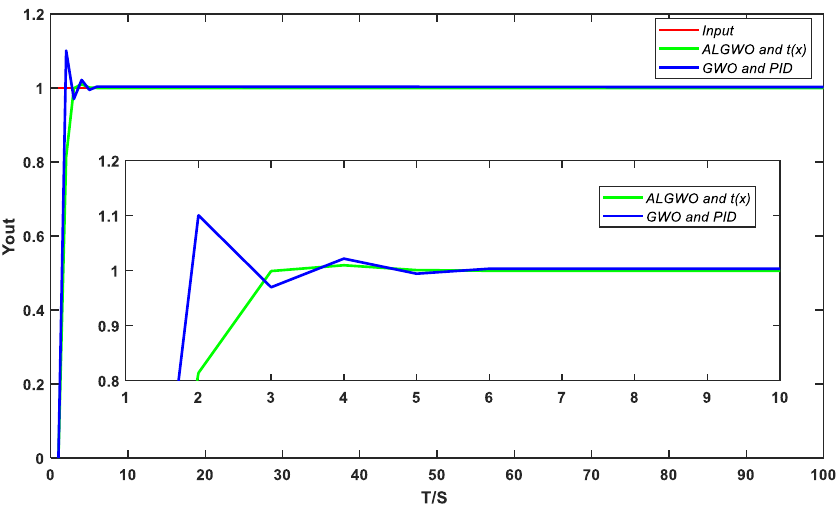
Figure 11. Step response.